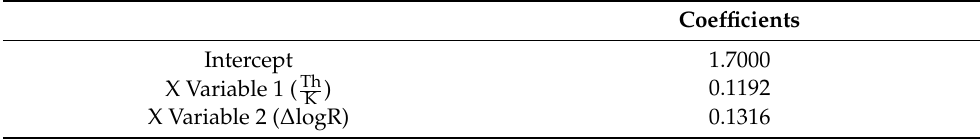
Table 6. Results of multivariate fitting of core TOC, Th/K, and ∆ log R in well B1.